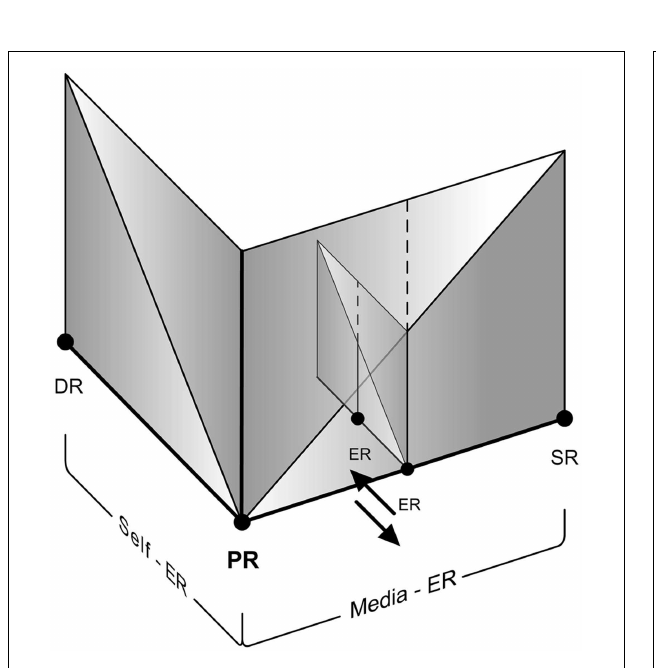
FIGURE 9 |An example of presence shift due to Self-ER within Media-ER (for e.g., thinking within a virtual environment).